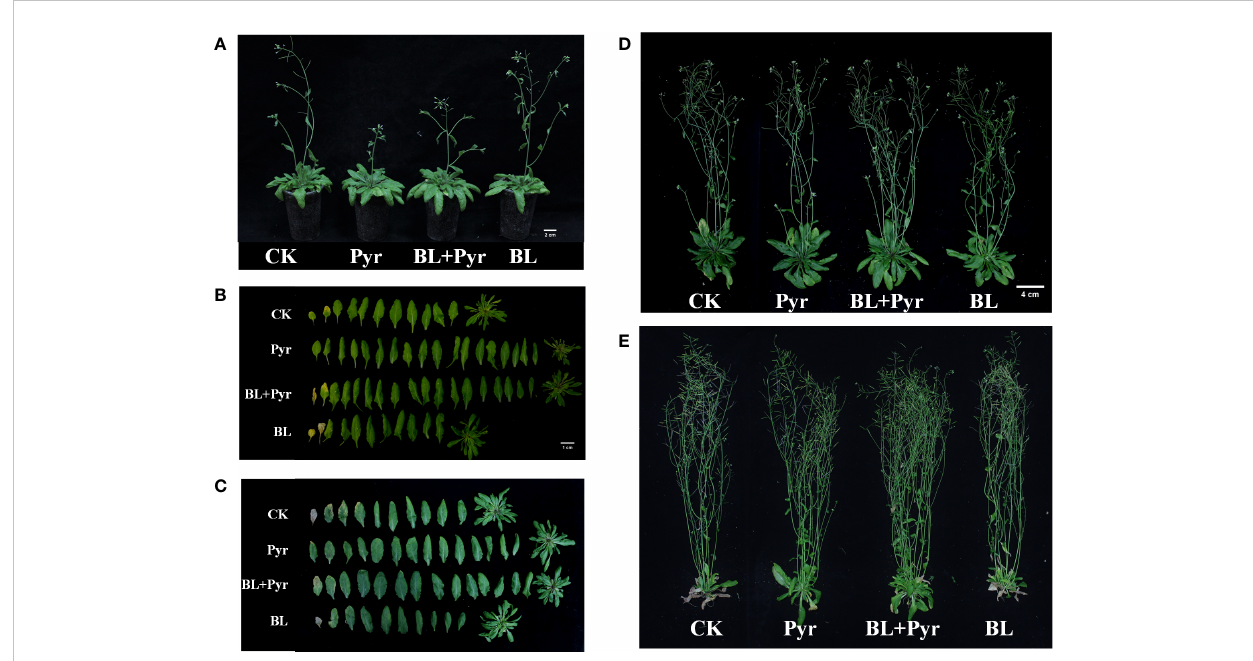
FIGURE 2 BL+Pyr increased the major axis and the fresh weight of rosette leaves and in fl orescence during the reproductive growth period. Photos were taken on the 4 th day after the second-round application ( A, B , 39-day-old seedlings), 16 th day after the second-round application ( C , D , 51-day-old seedlings), and 14 th day after the third-round application ( E , 69-day-old seedlings). CK, untreated seedlings; Pyr, seedlings treated with 3 m M pyraclostrobin; BL+Pyr, seedlings treated with 1 m M BL and 3 m M pyraclostrobin; BL, seedlings treated with 1 m M BL.